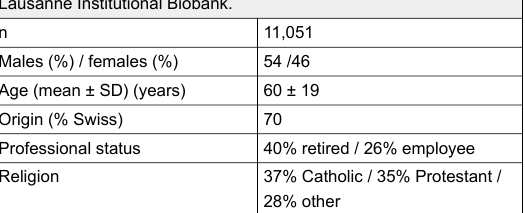
Table 1: Characteristics of the first 11,051 participants of the Lausanne Institutional Biobank.